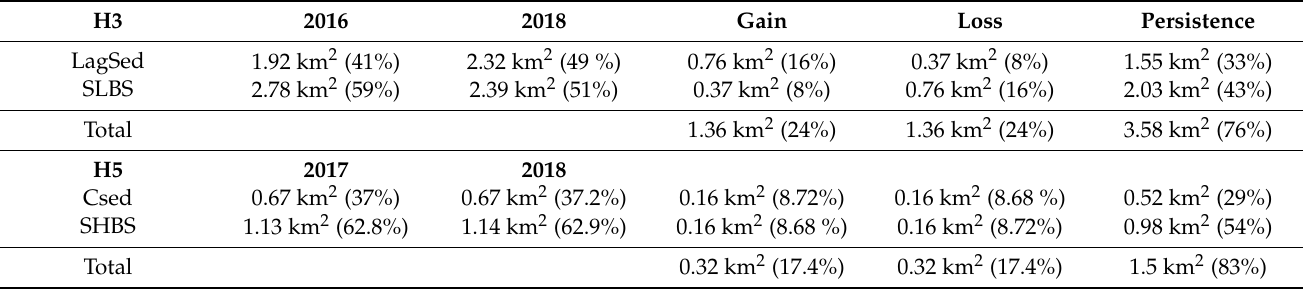
Table 7. Summary of the gains and losses per sediment class. Values presented are calculated in respect to the total study area (H3= 4.71 km 2 and H5 = 1.81 km 2